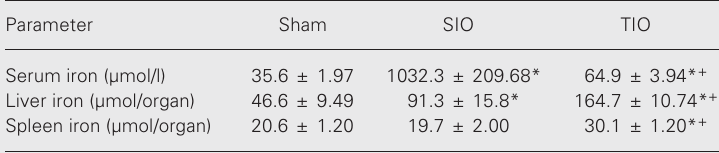
Figure 1. Baseline mean arterial pressure (A) and heart rate (B) of sham (open bar, N = 24), tis- sue iron overload (hatched bar, N = 19) and serum iron over- load (filled bar, N = 12) rats over a period of 10 min at the begin- ning of the recordings. Data are reported as mean ± SEM. *P